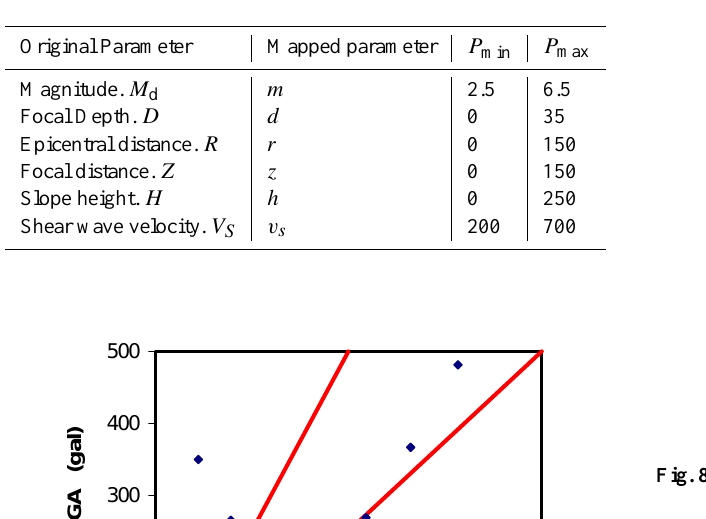
Table 5. Upper and lower limits of original data used for mapping